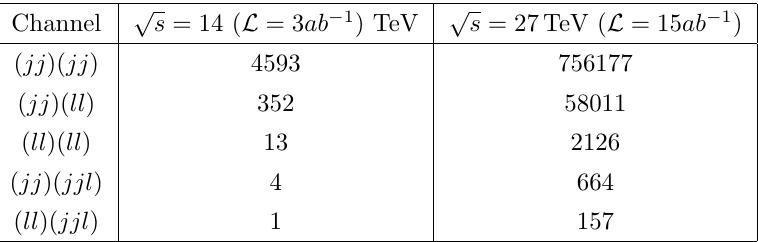
BR for BP1 at NLO for p s = 14 ( (cid:3)